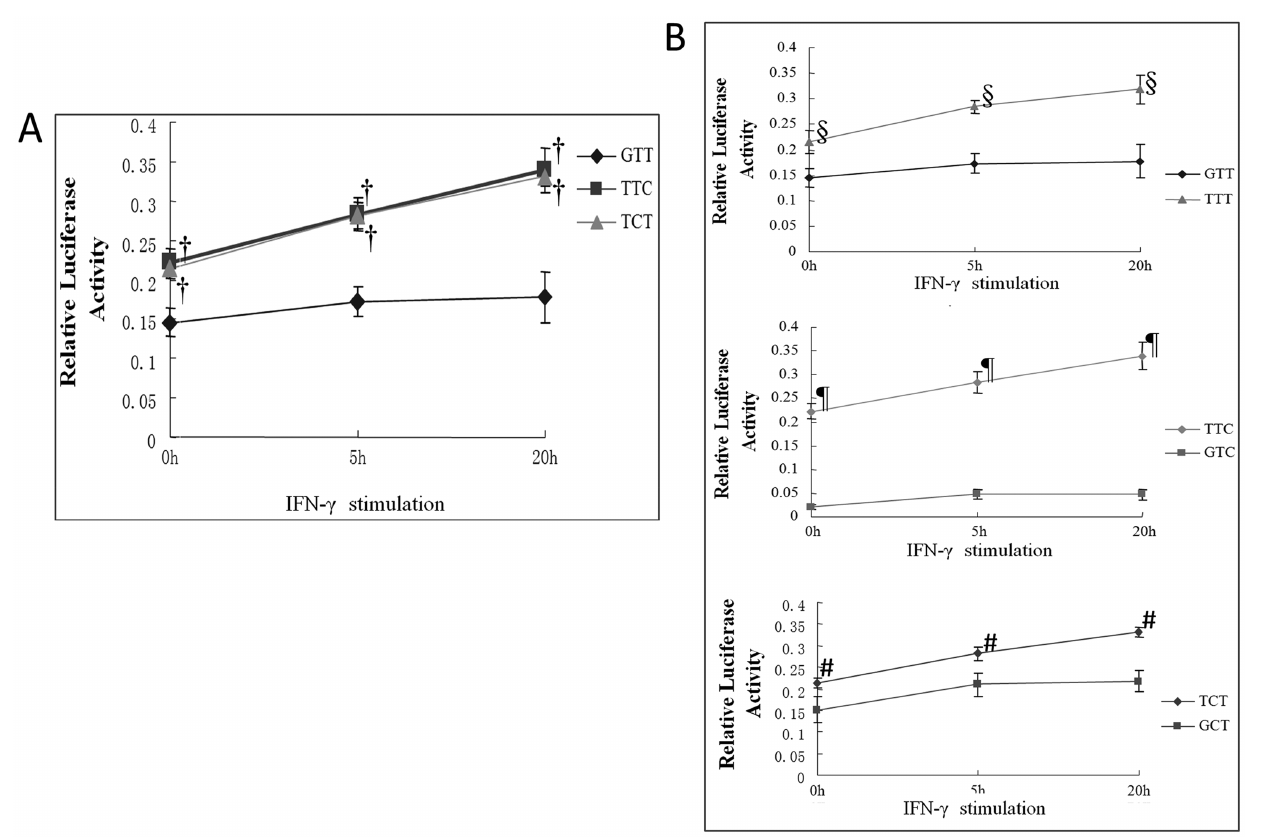
Figure 1. Promoter activity and gene expression analysis of IFITM3 . Data are shown as the mean of triplicate determinations 6 standard deviation (SD) and are representative of three independent experiments. Significant difference was defined as a P-value , 0.05 by two-tailed unpaired t test. (A) Dual luciferase assays for haplotypes composed of rs3888188, rs6598045, and rs7478728: comparison of the relative luciferase activities of the ‘GTT,’ ‘TTC,’ and ‘TCT’ haplotypes; { indicates significant difference in comparisons of both GTT vs. TTC and CTT vs. TCT. (B) Dual luciferase assays for haplotypes before and after site-directed mutagenesis: 1 indicates a significant difference for GTT vs. TTT, " for GTC vs. TTC, and # for GCT vs. TCT.